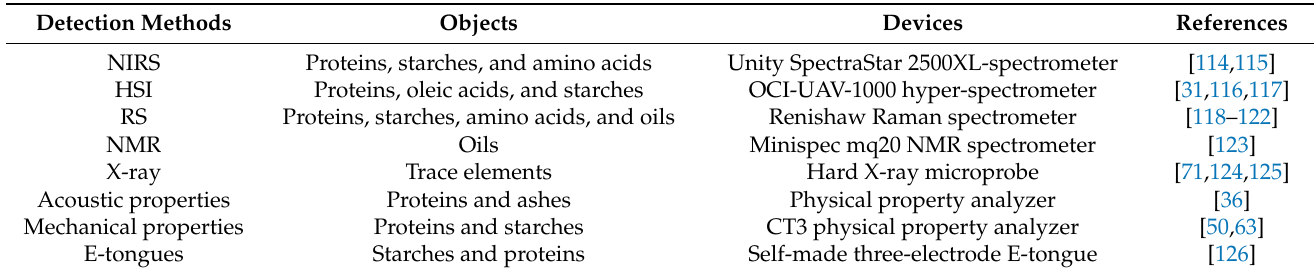
Table 3. Non-destructive detection methods for nutritional attributes of cereal